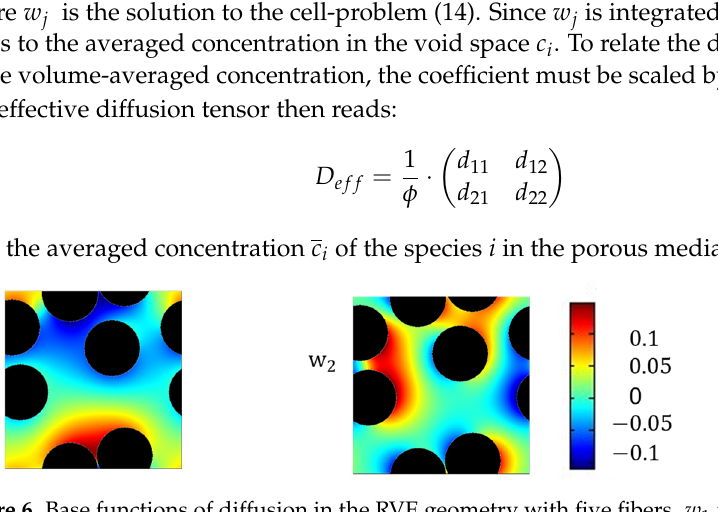
Figure 7. Schematic flow chart to determine constitutive correlations for mass transport in fibrous media. In the first step, the virtual RVEs are created in order to represent the characteristic microstructure of the considered material. For a fixed porosity, a representative number of RVEs are created to represent the average geometrical configuration. In the next step, the cell problems (8) and (14) are solved on a set of RVEs, which are randomly generated taking porosity and fiber diameter as a constraint. Finally, the transport properties ob- tained by the simulations are fitted to correlations (2) and (4). This averages the transport coefficients over all random geometries at a given porosity  . 3. Results and Discussion In this section, we present the simulation results and improved constitutive correla- tions for mass transport in fibrous media. To demonstrate the impact of random ordering, we compare our proposed correlations to correlations by Gebart [8].